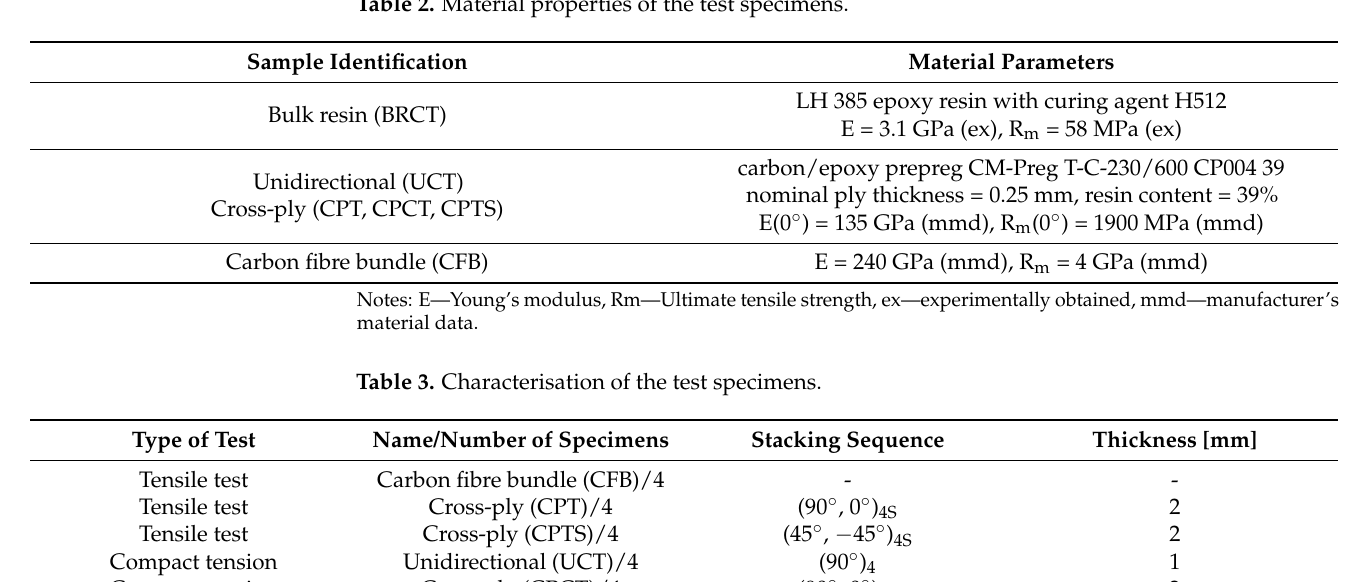
Table 2. Material properties of the test specimens.